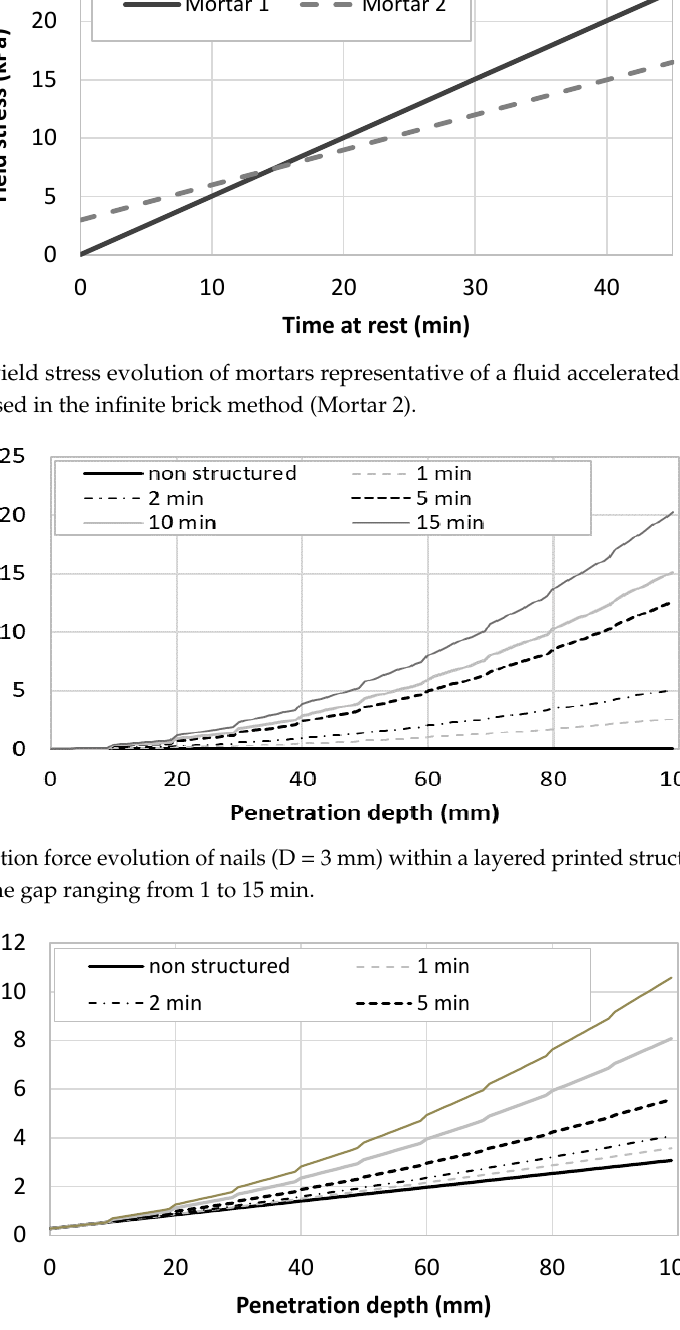
Figure 6. Penetration force evolution of nails (D = 3 mm) within a layered printed structure of Mortar 2 with di ff erent time gap ranging from 1 to 15 min.